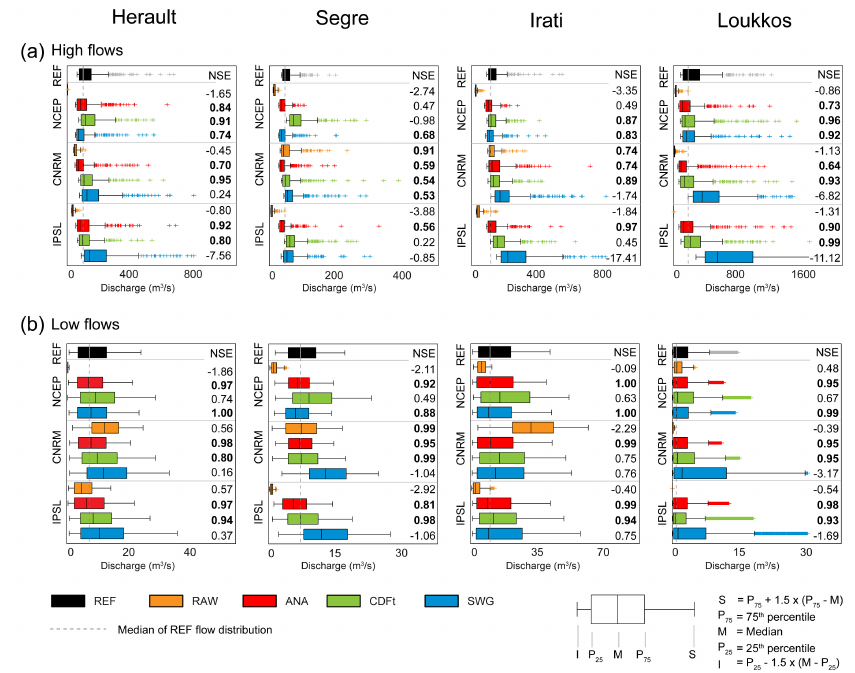
Figure 9. Comparison of (a) the 5% daily high flows and (b) the 80% daily low flows simulated with REF data, RAW (NCEP or GCM) data, and the three downscaling methods (applied to NCEP, CNRM and IPSL) for each basin. The NSE values calculated on the 5% high and the 80% low flows are indicated on the right in each panel. NSE values higher than 0.5 for high flows and 0.8 for low flows are in